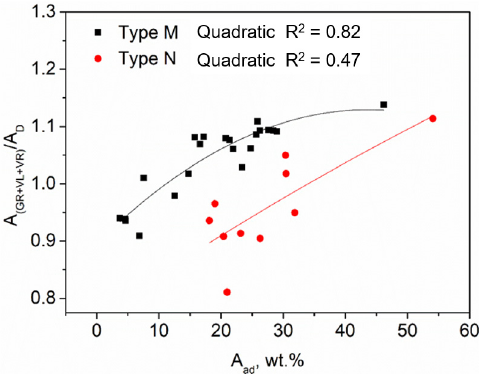
Figure 7. The correlation between A ad in parent coal and A (GR+VL+VR) /A D of its pyrolytic char.